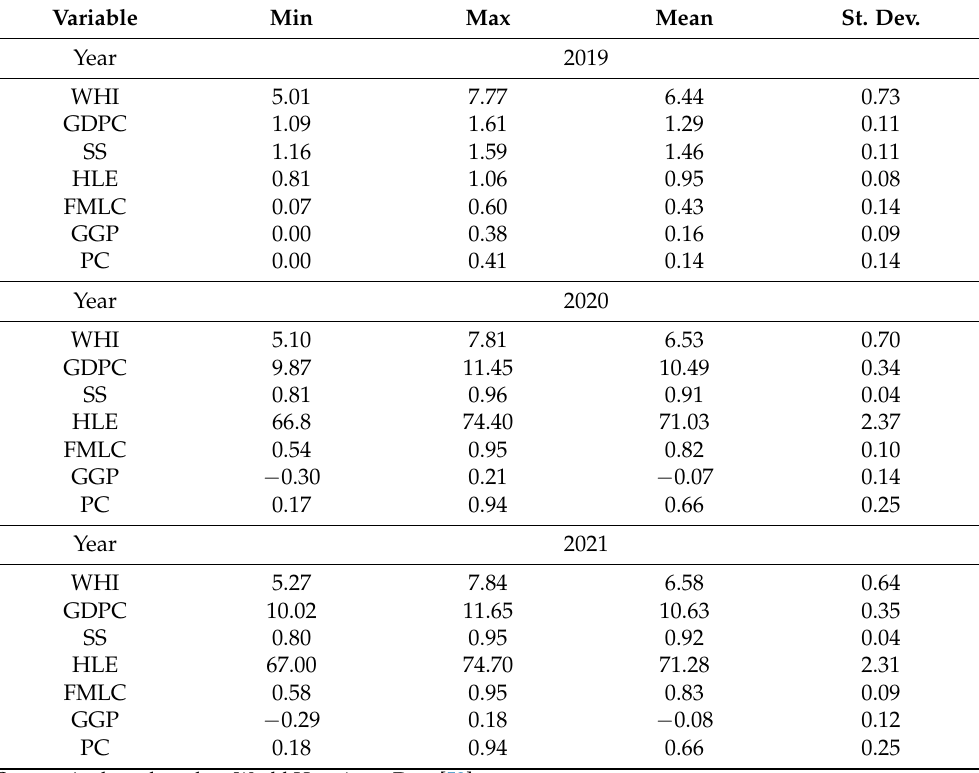
Table 4. Descriptive statistics of the WHI variables for the period 2019–2021. Variable